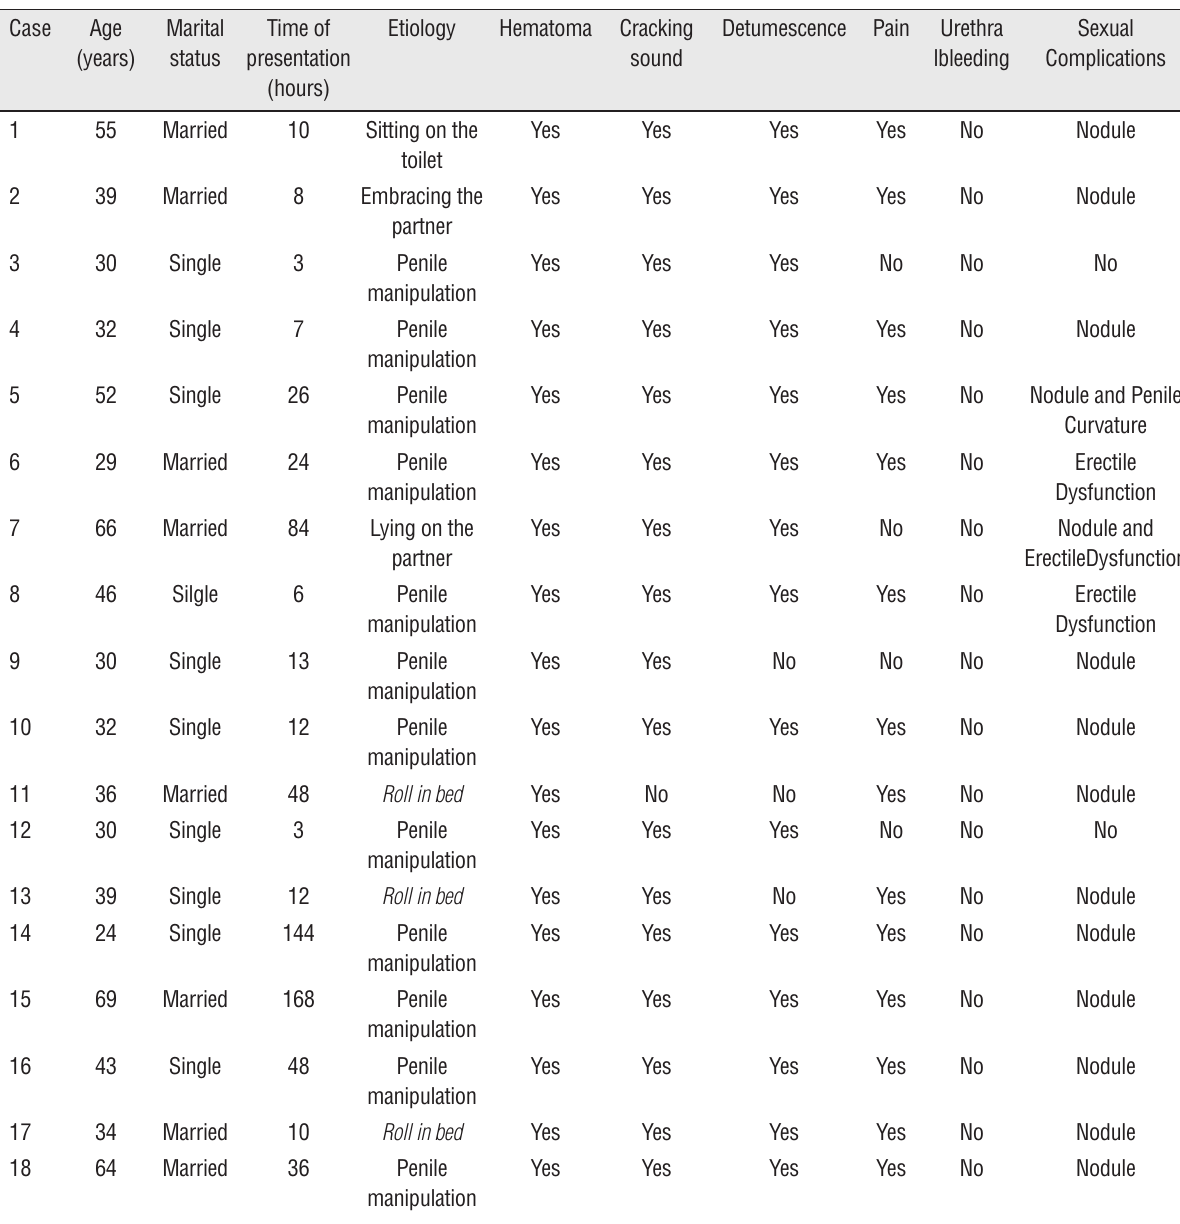
Table 2 - Demographics, clinical findings and sexual complications.